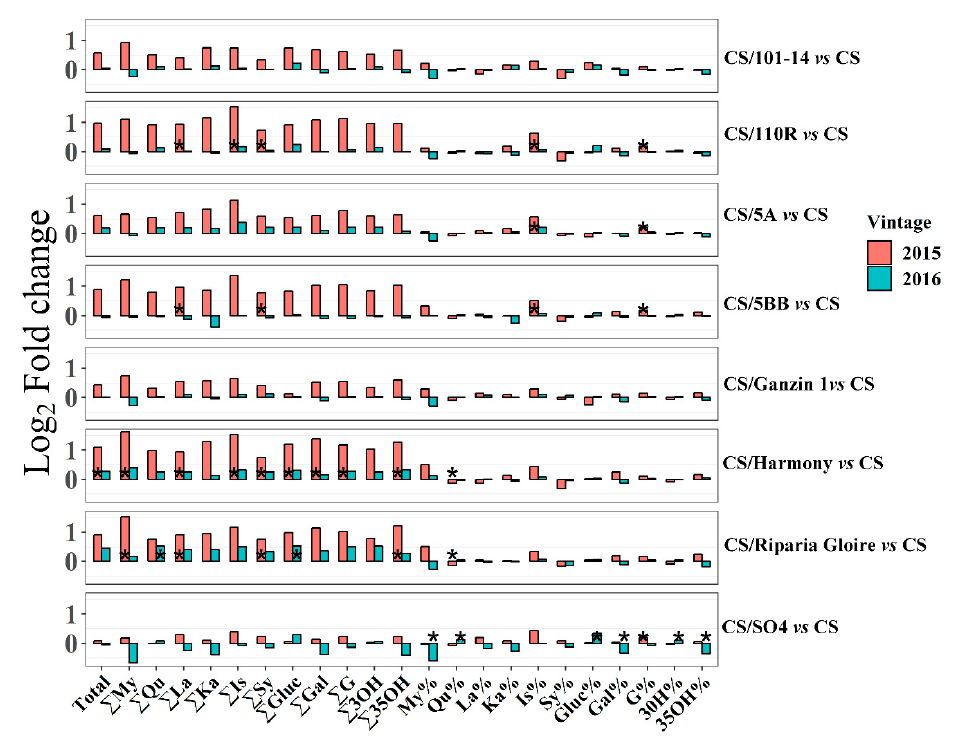
Figure 2. Effects of each rootstock on flavonols in two seasons (2015–2016). Each data represent the log2 fold change of flavonol concentrations/proportions in berries on each grafted vine relative to those on own-rooted vines. ‘Total’, the concentration of total flavonols; ‘ ∑ ’, the total concentration of different fractions of flavonols; ‘%’, the proportions of different fractions of flavonols; ‘My’, myricetin; ‘Qu’, Quercetin; ‘La’, laricitrin; ‘Ka’, kaempferol; ‘IS’, isohamnetin; ‘Sy’, syringetin; ‘Gluc’, flavonols in glucuronide form; ‘Gal’, flavonols in galactoside; ‘G’, flavonols in glucoside form; ‘3OH’, 3 ′‐ hydroxylated flavonols; ‘35OH’, 3 ′ 5 ′‐ hydroxylated flavonols. The asterisk * in each bar indicates significant differences between grafted and own-rooted vines in the same season at the basis of students’ t -test at p < 0.05.